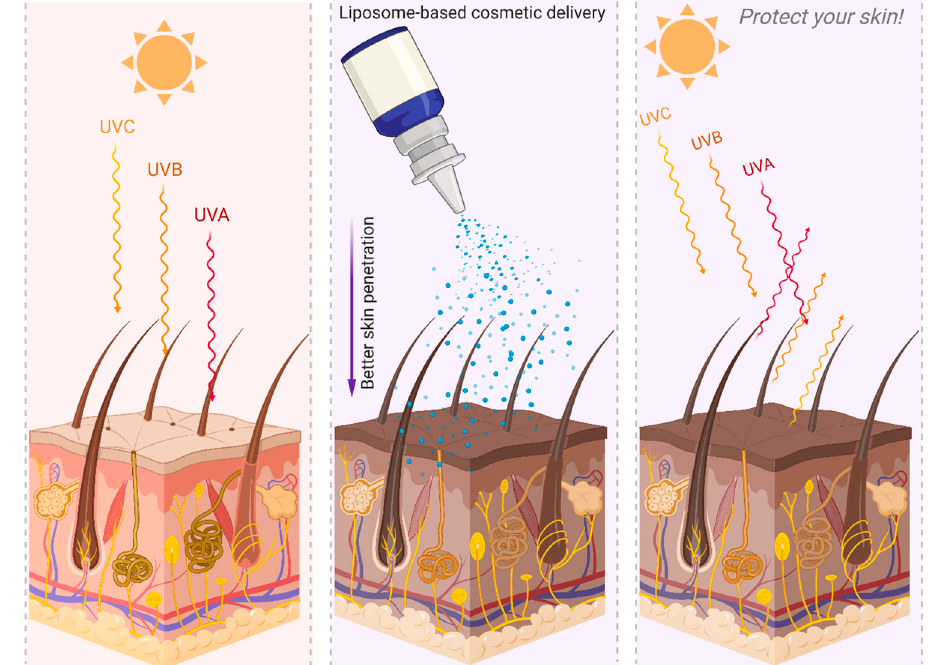
Figure 2. Liposome-based cosmetic delivery via the skin. The liposome-incorporated cosmeceutical formulations offer better skin penetration and help to protect the skin from harmful radiations. The figure was created with the “BioRender.com” template and exported under the terms of premium subscription.